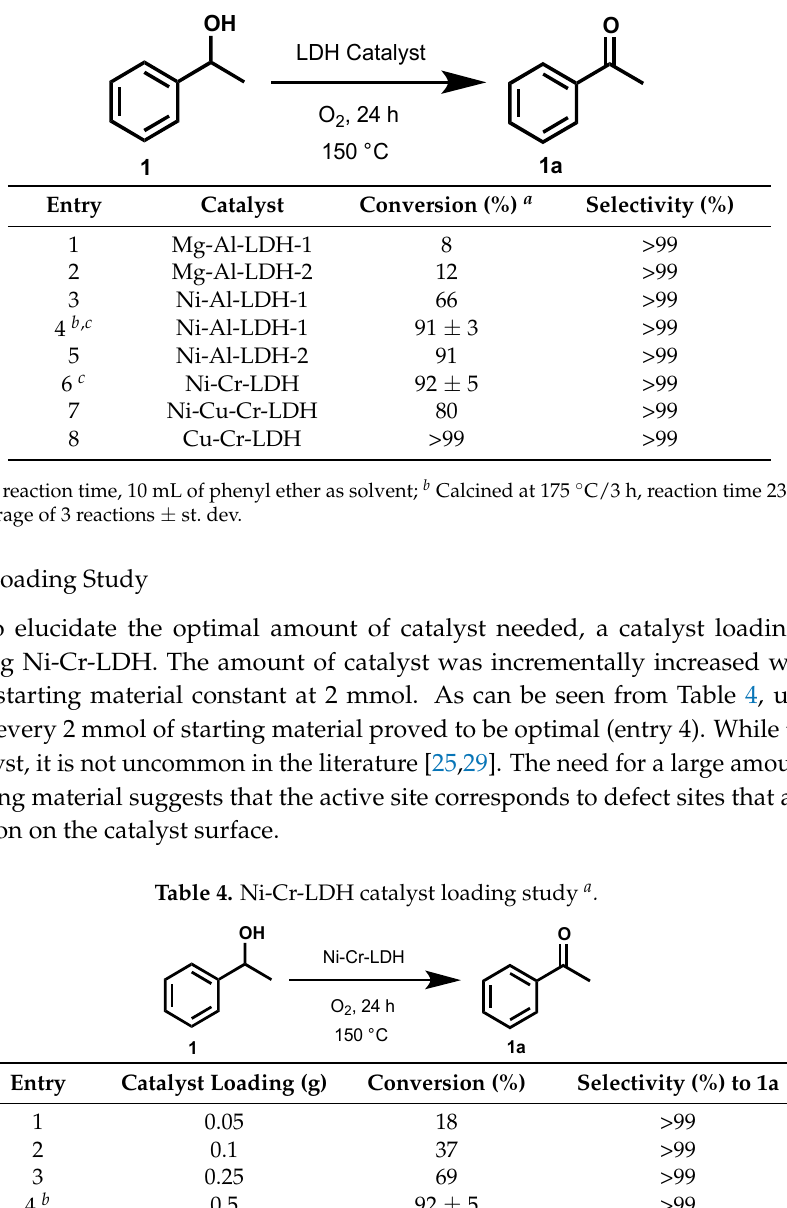
Table 3. Conversion of 1 ‐ phenyl ethanol, 1 to acetophenone, 1a in phenyl ether with various LDH catalysts.